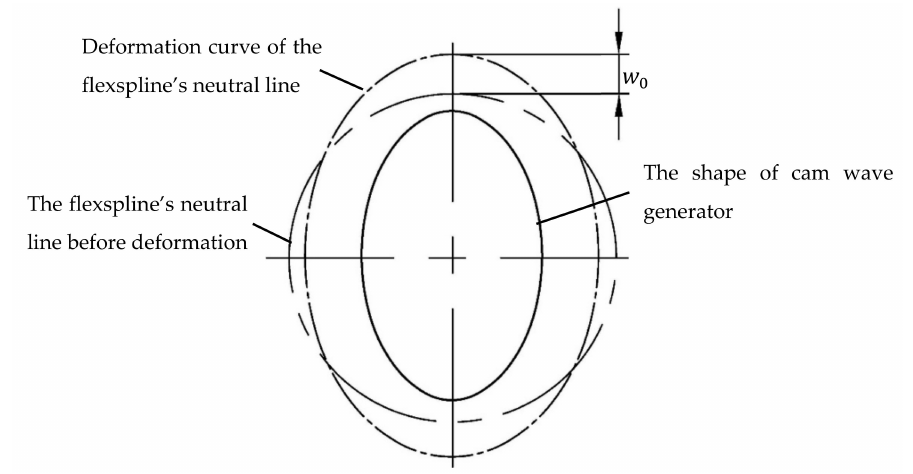
Figure 2. Forced deformation with cam wave generator. Adapted from ref.